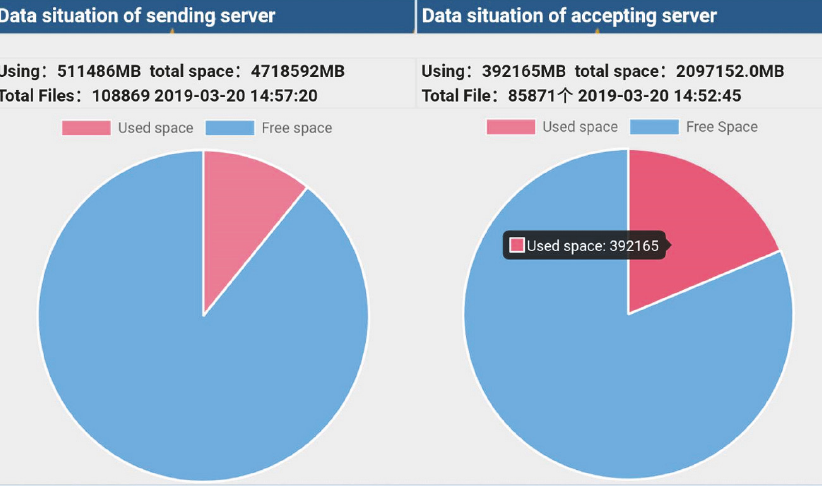
Figure 11: The third part of visualization web